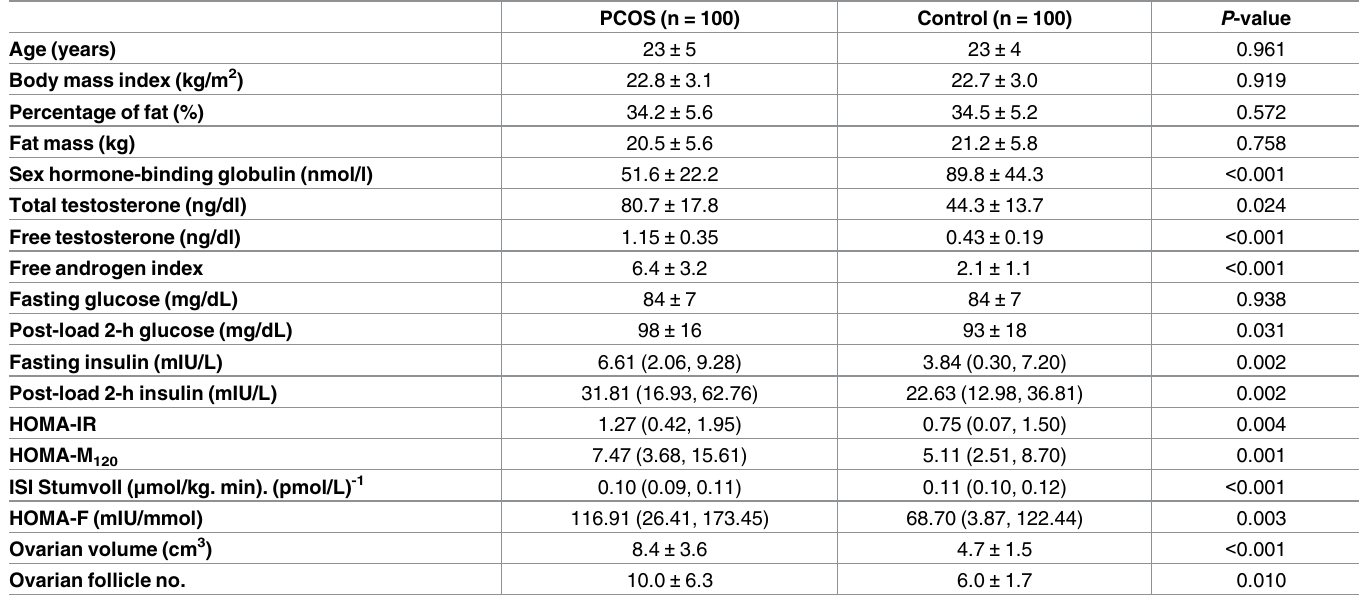
Table 1. Clinical and biochemical characteristics.